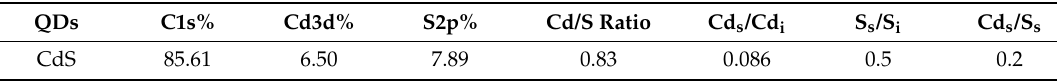
Figure 3. XPS elemental analysis of CdS QDs. ( a ) and ( b ) are XPS counts of Cd 3d electrons and S 2p electrons, respectively. Black dots represent raw XPS data, green lines are Gaussian curve fits at energies corresponding to core atoms, blue lines are Gaussian curve fits centered at energies corresponding to electrons from atoms on the surface, and red lines represent convolution of blue and green lines. Cd signals included contributions from Cd 3d 3/2 and 5/2 electrons, S signals included contributions from S 2p 1/2 and 3/2 electrons. Table 1. XPS elemental analysis of CdS QDs. The table shows the atomic percentage of elements from raw XPS data. Surface-to-inner ratios of Cd and S (Cds/Cdi and S s /Si) were calculated from the integrated peak area fitted from Cd and S signals in the XPS data.